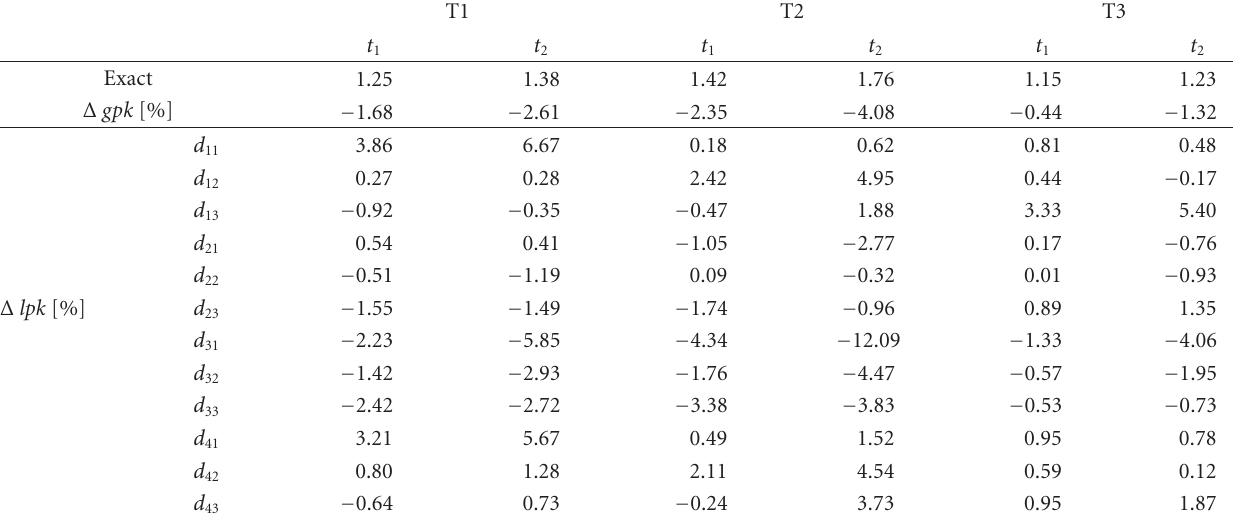
Figure 7: Weights adopted for the generation of the point kinetic models for the prediction of the local fluxes. Table 2: Performance of gpk and lpk for the prediction of the system power during a transient induced by localized perturbations. Values of Δ P are computed as relative percentage errors with respect to the corresponding reference values at two di ff erent time instants along the transient ( t 1 = 1ms and t 2 =